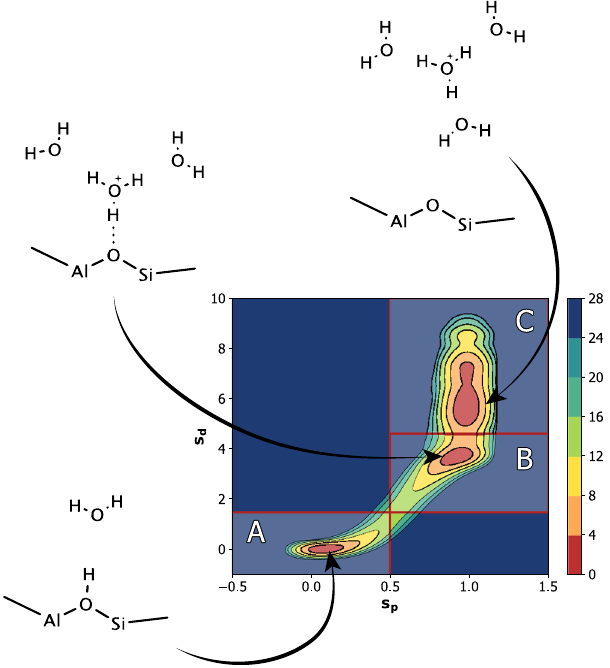
Fig. 3 Explicative free energy surface. The FES projected along s p and s d shows three basins corresponding to the three different con fi gurations that occur during hydronium formation. Colorbar reports free energy differences expressed in kJ mol − 1